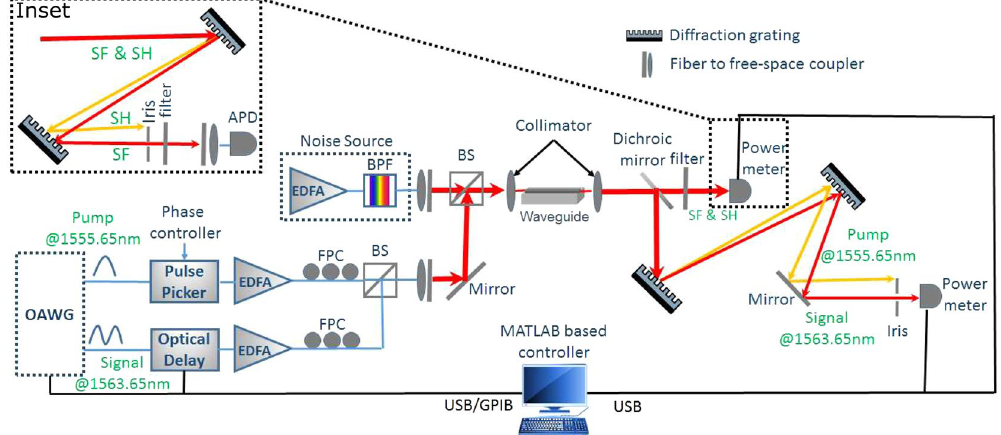
Figure 3. Experimental setup for QPMS. Pump and signal pulses are created via OAWG originally at 25 GHz repetition rate and downclocked using pulse pickers. The depleted signal and generated sum-frequency light are measured as a function of temporal delay between the input pump and signal. BPF: bandpass filter, FPC: fiber polarization controller, BS: beam splitter, 3DTS: 3 dimensional translation stage, APD: Avalanche photodiode. The spectral filtering bandwidths are 1 nm and 0.8 nm at FWHM for SF and signal path, respectively.